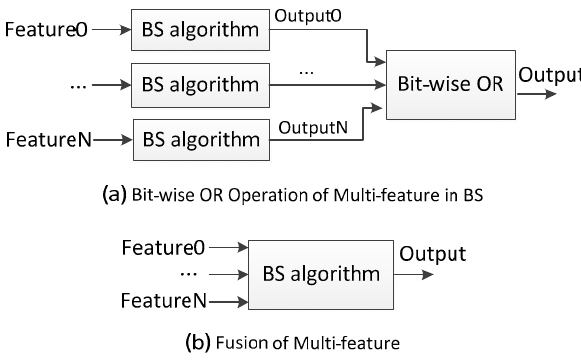
Figure 2. Multi-feature fusion and bit-wise OR operation in background subtraction.